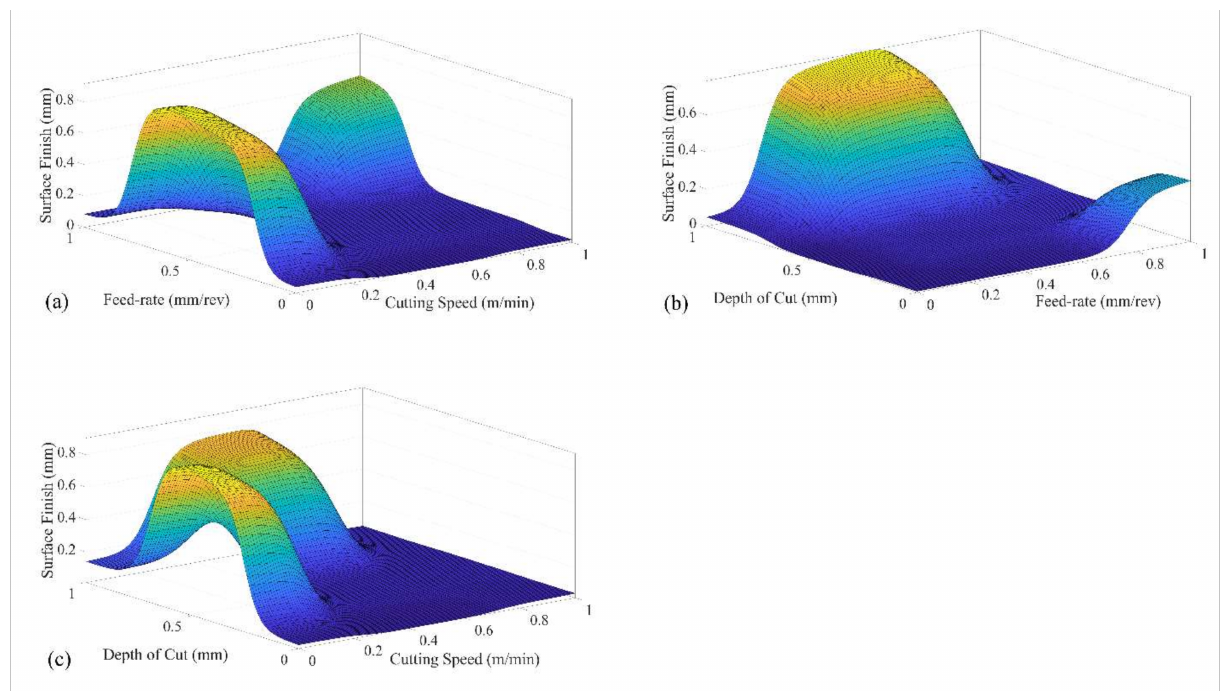
Figure 9. The ruled surface of ANFIS-2 (ANFIS-TW) in terms of cutting parameters ( a ) TW at feed-rate and cutting speed; ( b ) TW at depth of cut and feed-rate; ( c ) TW at depth of cut and cutting speed.